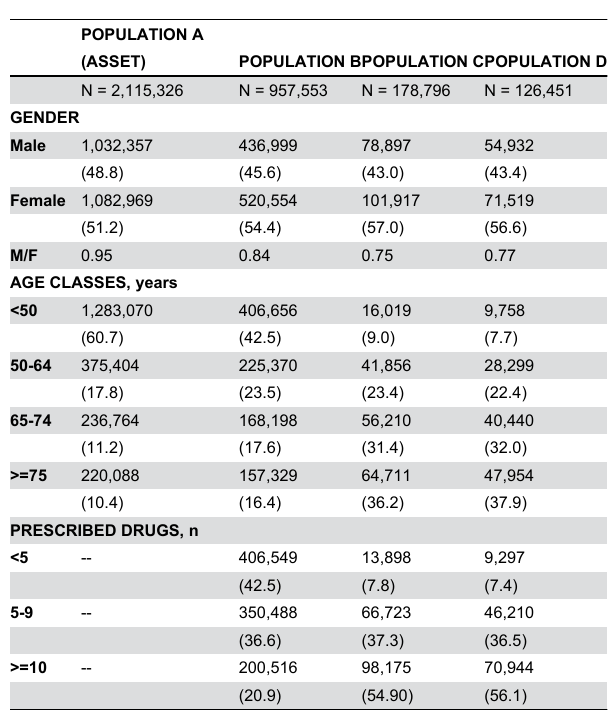
Table 2. Main characteristics of the populations, N (%). Table 3. Adjusted odds ratios (95% CI) of concomitant prescription or co-prescription for gender, age, and number of prescribed